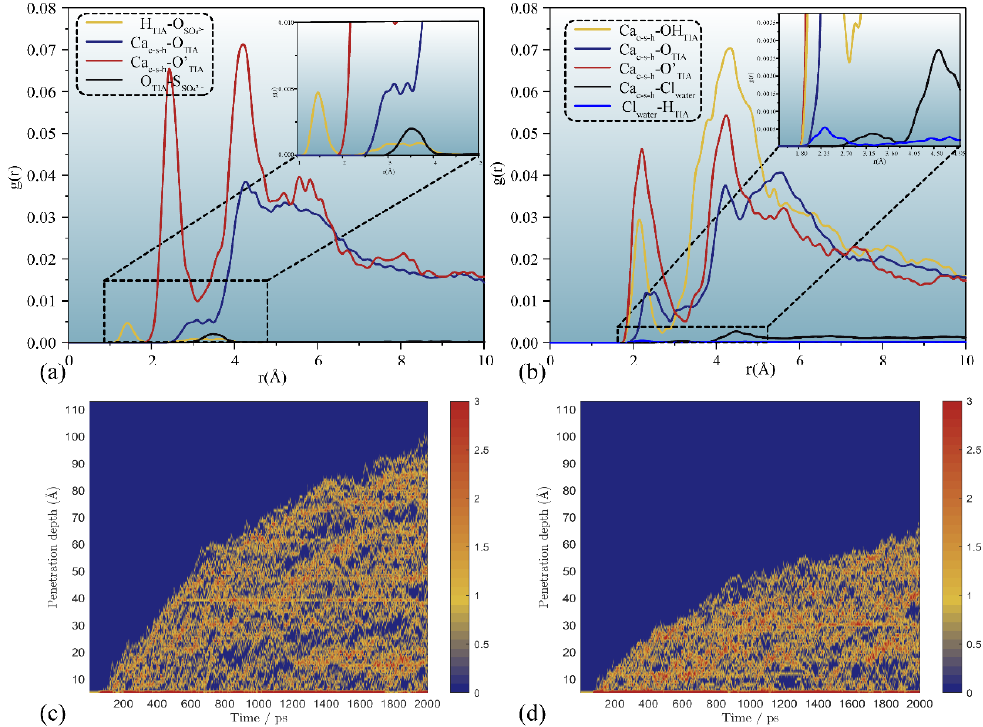
Figure 9. Radial distribution function among erosion medium, matrix and polymer atoms in the percolation process of ( a ) sodium sulfate solution and ( b ) sodium chloride solution and chloride ion percolation depth diagram in sodium chloride solution ( c ) without TIA ( d ) with TIA.